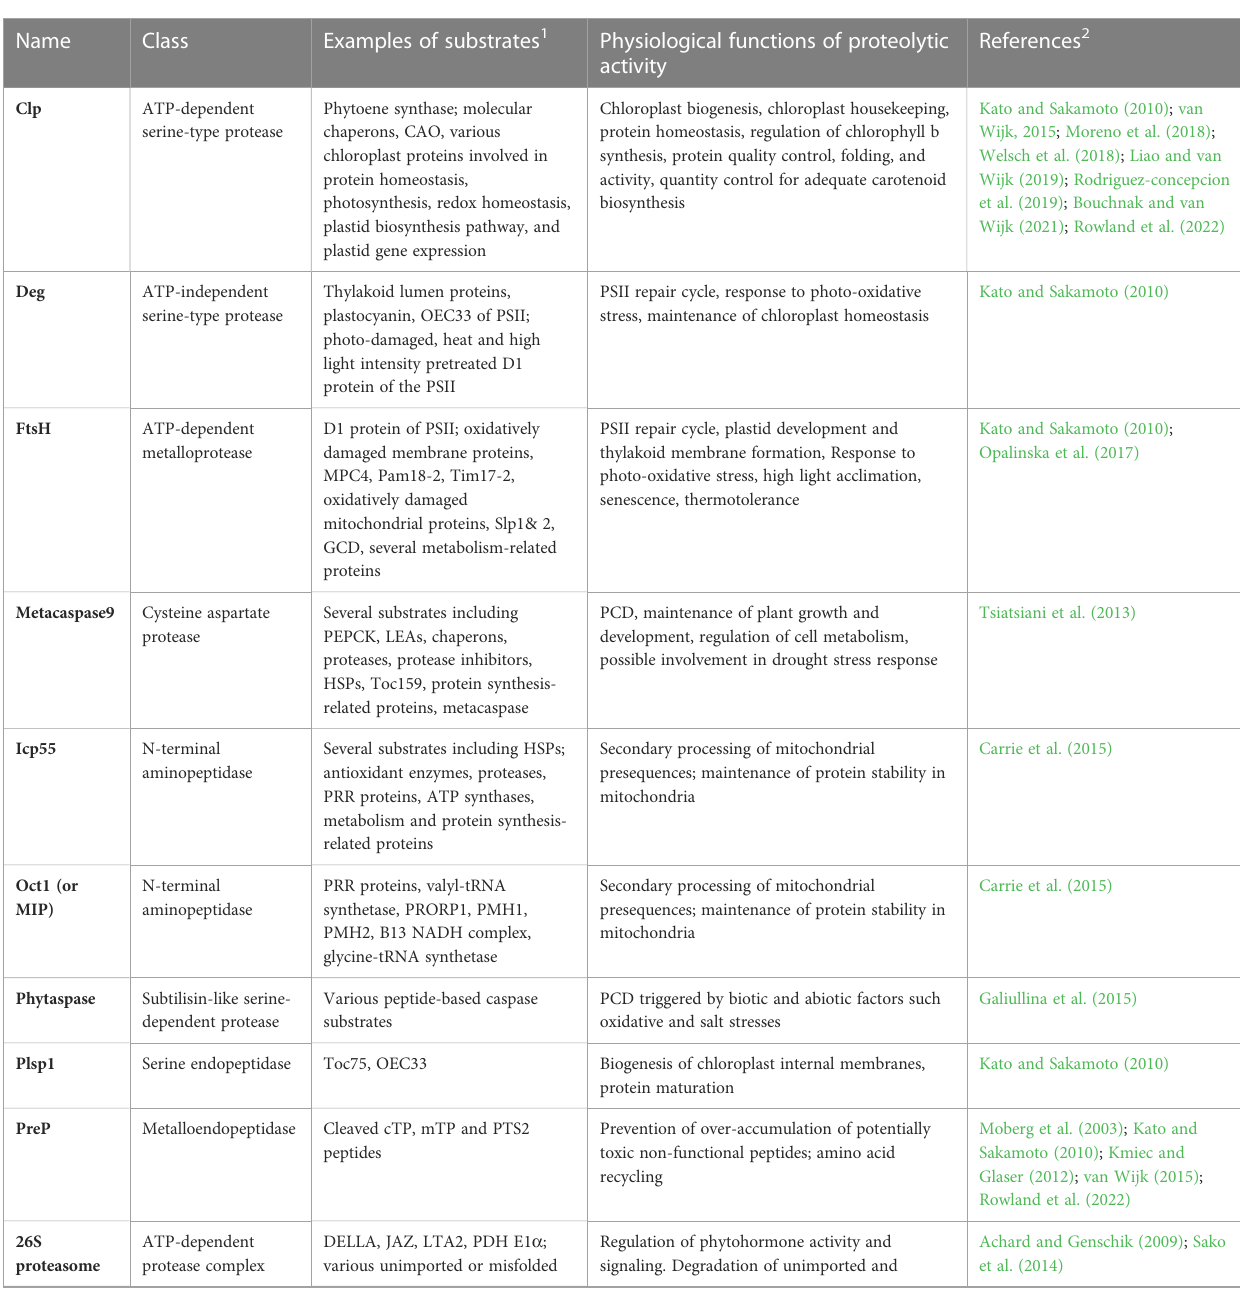
TABLE 2 Examples of protein substrates for selected proteases and peptidases during plant growth and